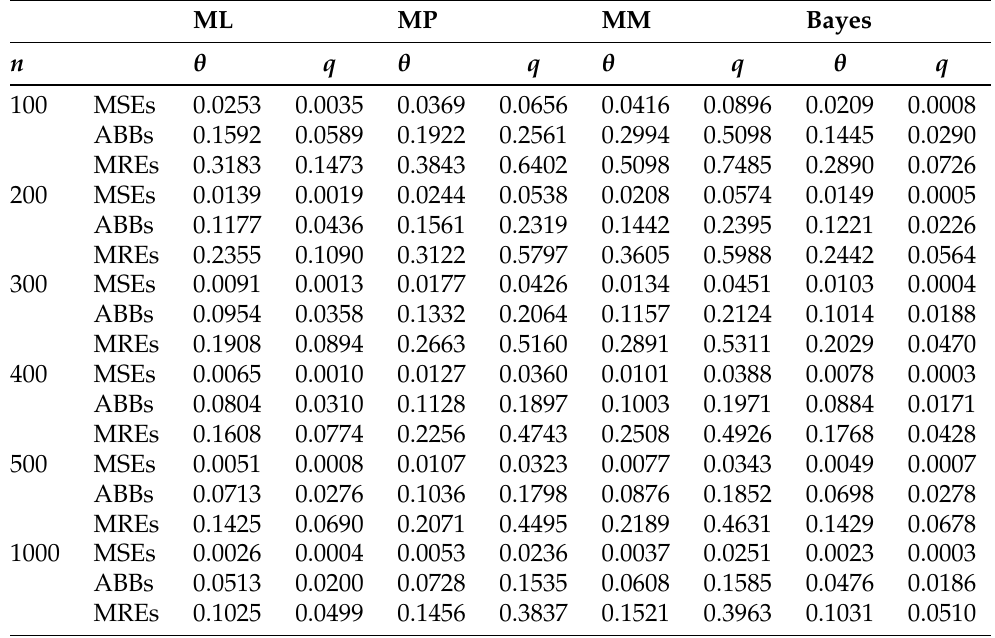
Table 3. Simulation results of the TRTG model for θ = 0.5 and q =